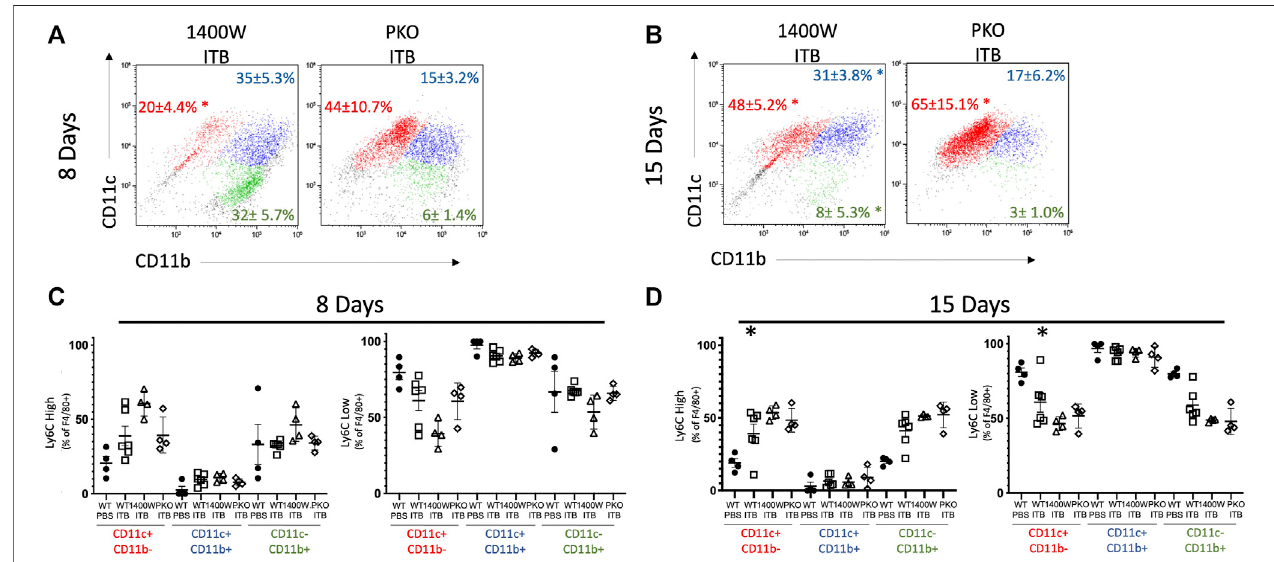
FIGURE10| SystemicandpulmonarylossofiNOSaltersMoMresponsetoITB.MoMmaturityandproin fl ammatoryactivationfollowingITBin1400 Wtreatedand PKO chimeras. (A – B) MoM expression of CD11c and CD11b 8 (A) and 15 (B) days post ITB. (C – D) Ly6C expression is gated as either high or low at 8 (C) and 15